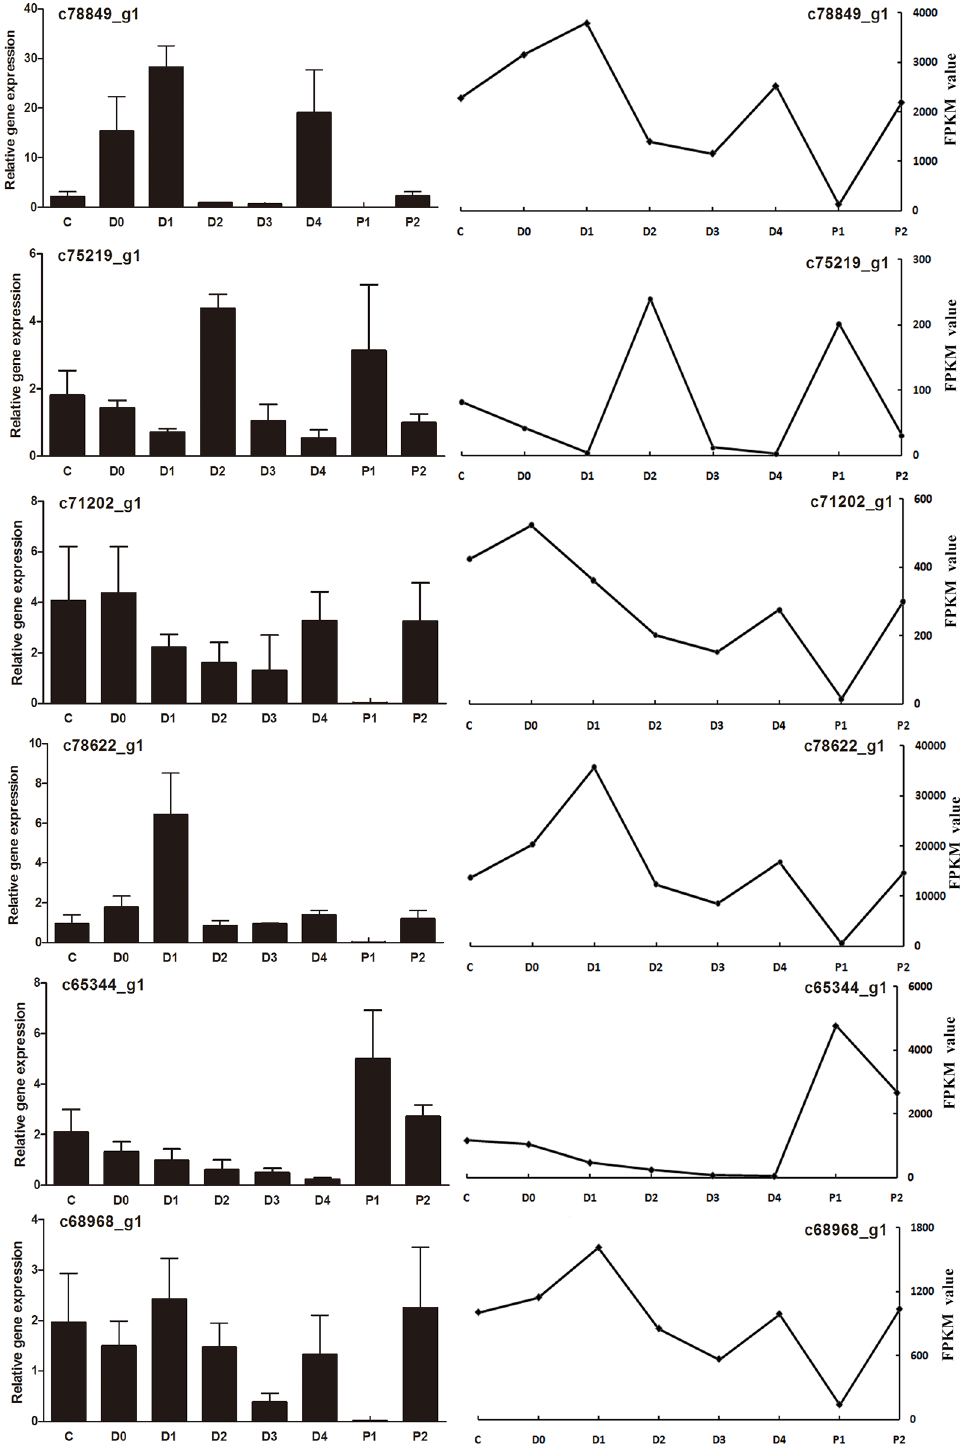
Fig 7. Real-time quantitative PCR (qRT-PCR). Six candidate genes were selected randomly for validation. Expression results of qRT-PCR are shown on the left and expression profiles of RNA-sequencing on the right. The gene c82047_g1 ( Actin T2 ) was used as the control reference gene.